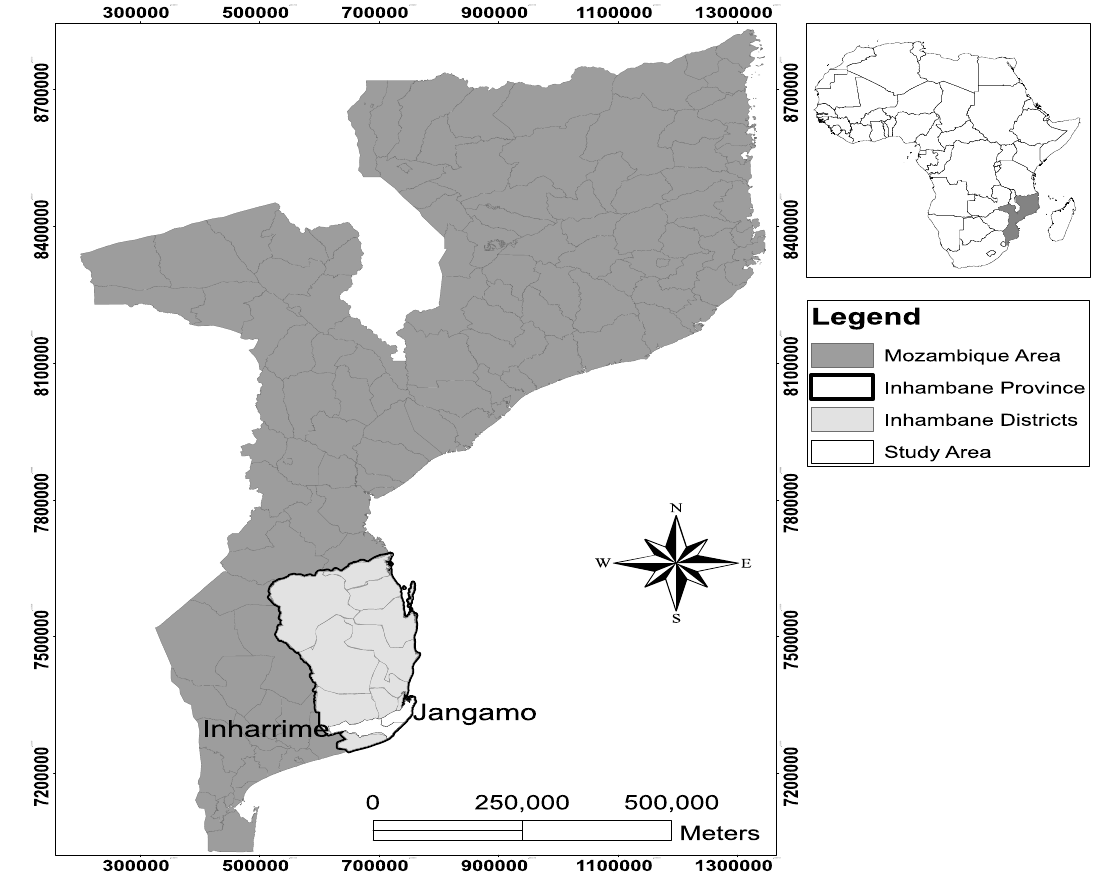
Figure 1. Location of the study area. Geographic coordinates in UTM.